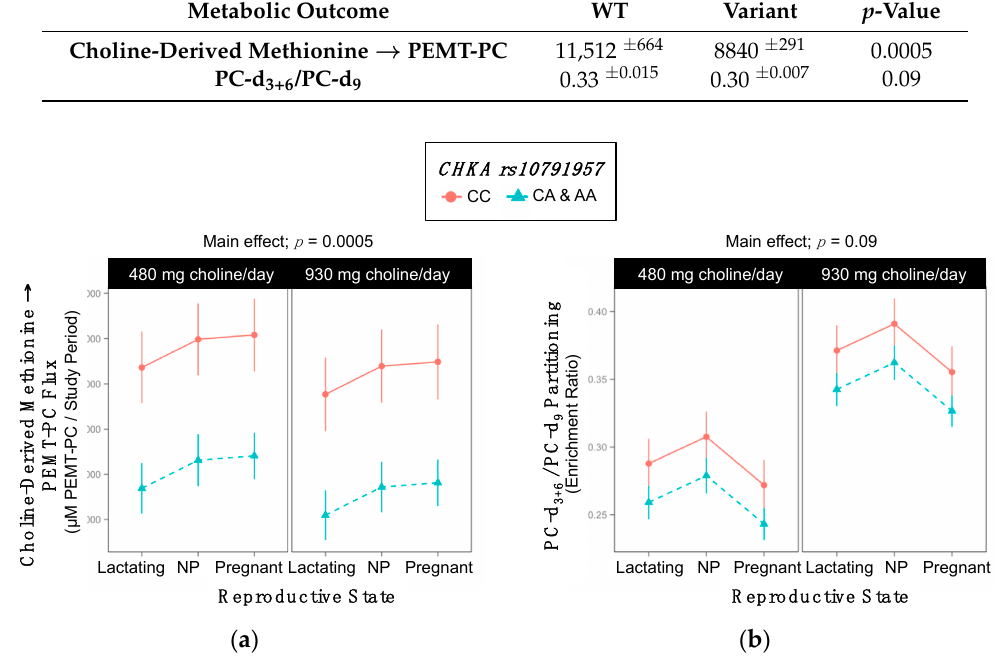
Figure 2. Effect of the CHKA rs10791957 variant on the metabolic flux and partitioning of dietary choline. ( a ) Choline-derived methionine → PEMT-PC flux; ( b ) PC-d 3+6 /PC-d 9 partitioning.